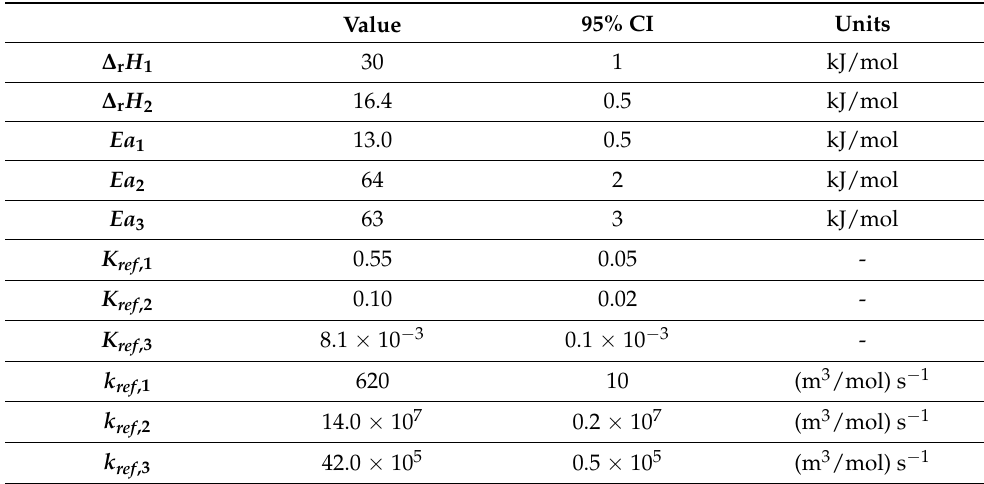
Table 2. Parameter estimation results. CI: confidence interval at